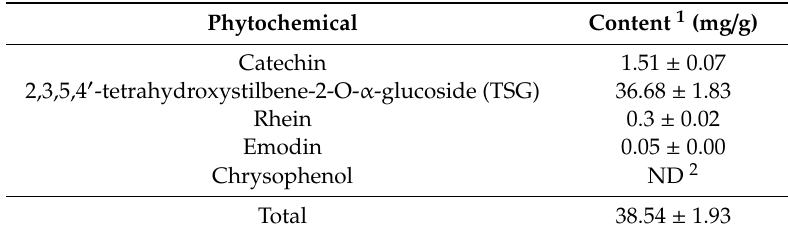
Table 1. Phytochemical contents in the Polygoni multiflori (PM) extract.